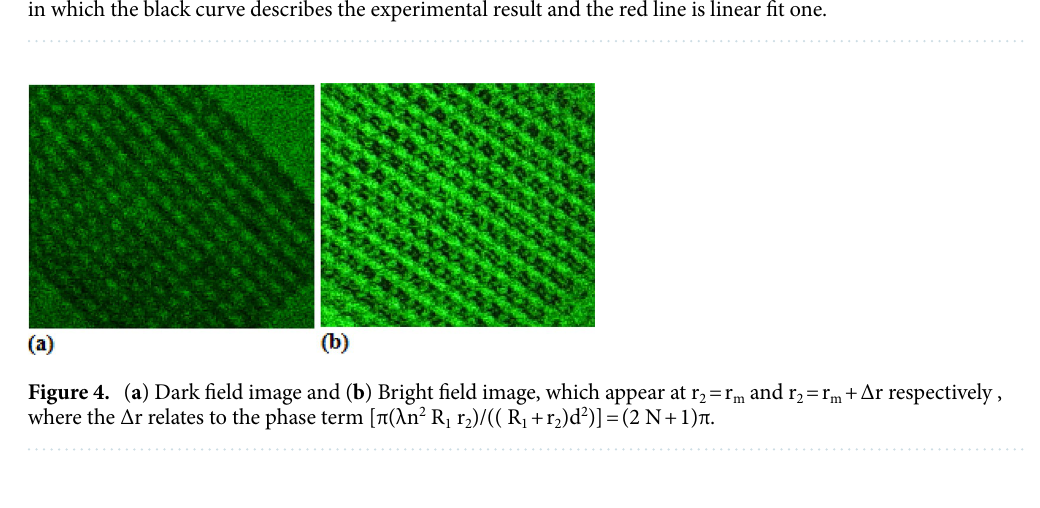
Figure 3. The curve of relationship between the Talbot interval and the imaging distance in the LRTM process, in which the black curve describes the experimental result and the red line is linear fit one.